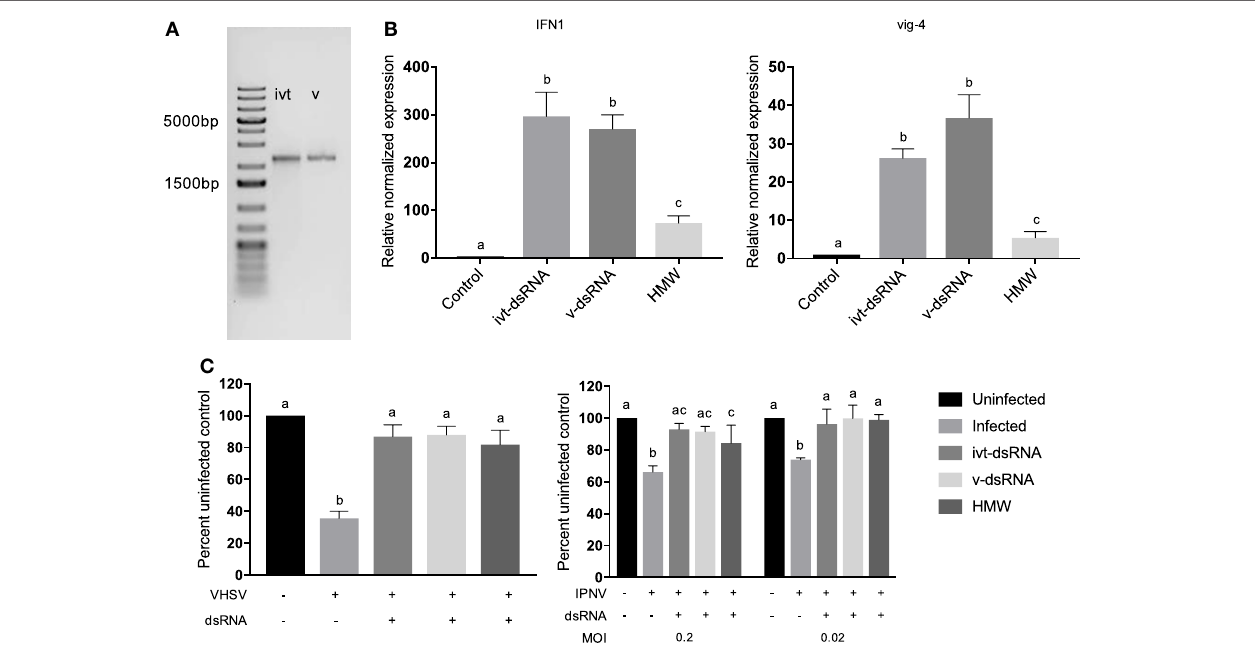
FigUre 4 | Length- and sequence-matched ivt- and v-dsRNA induced similar levels of IFN1 and vig-4 transcripts and similar antiviral state against viral hemorrhagic septicemia virus (VHSV) and infectious pancreatic necrosis virus (IPNV) infections in RTG-2 cells. A segment of the chum salmon reovirus genome (segment 6, 2,052 bp) was isolated (v-dsRNA), and a length- and sequence-matched dsRNA molecule was transcribed in vitro (ivt-dsRNA). High-molecular weight (HMW) polyinosinic:polycytidylic acid was included as a treatment control. (a) 20 ng of the isolated segments was run on a 1% agarose gel stained with ethidium bromide for visualization. (b) RTG-2 cells were treated with 0.01 nM dsRNA for 3 h, and IFN1 and vig-4 transcripts were measured by qRT-PCR, normalized to β -actin, and presented as values relative to an unstimulated control. (c) RTG-2 cells were pretreated with 0.01 nM dsRNA for 6 h and then infected with VHSV at a multiplicity of infection (MOI) of 10 or IPNV at an MOI of 0.2 or 0.02. After 4–7 days, a fluorescent indicator dye, alamarBlue, was used to measure cell viability, and data are presented as the percentage of an untreated, uninfected control. Data represent least three independent replicates and were analyzed statistically by one-way ANOVA (b) or two-way ANOVA (c) , alpha = 0.05; a P value < 0.05 considered